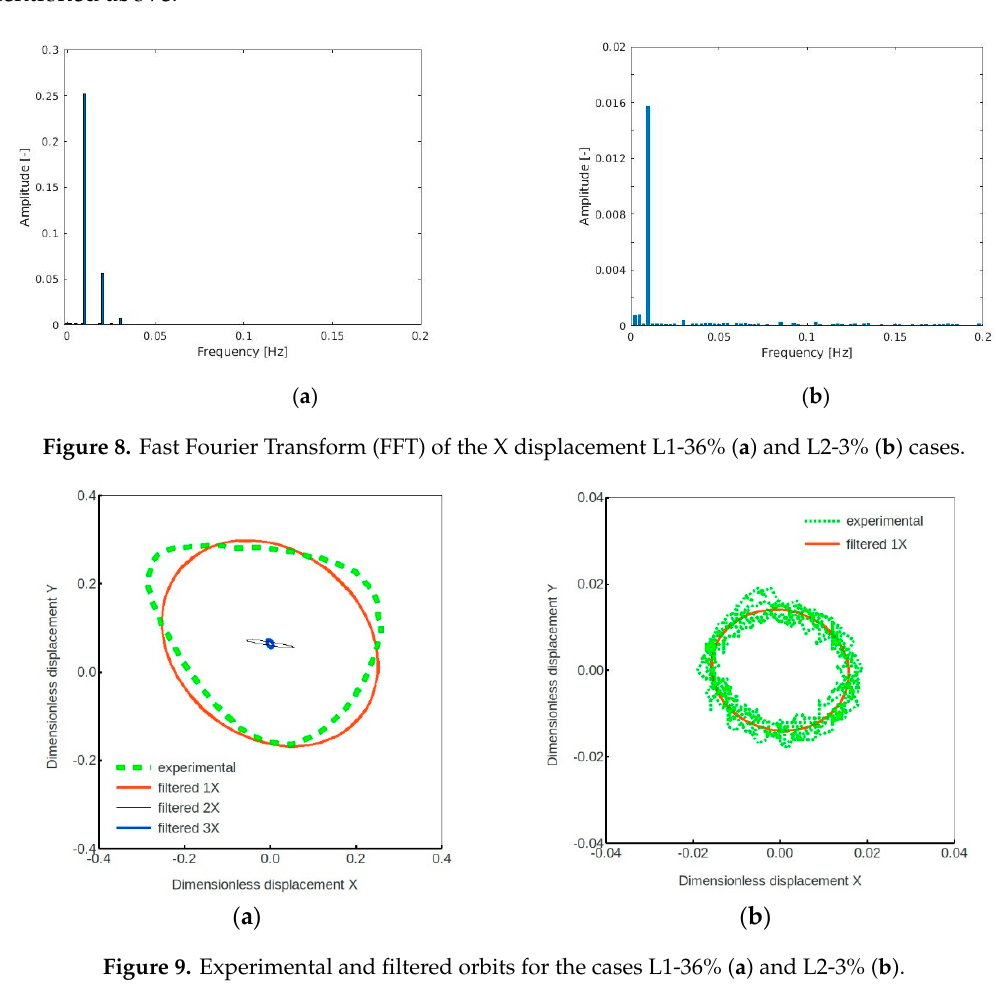
Figure 9. Experimental and filtered orbits for the cases L1-36% ( a ) and L2-3% ( b ).